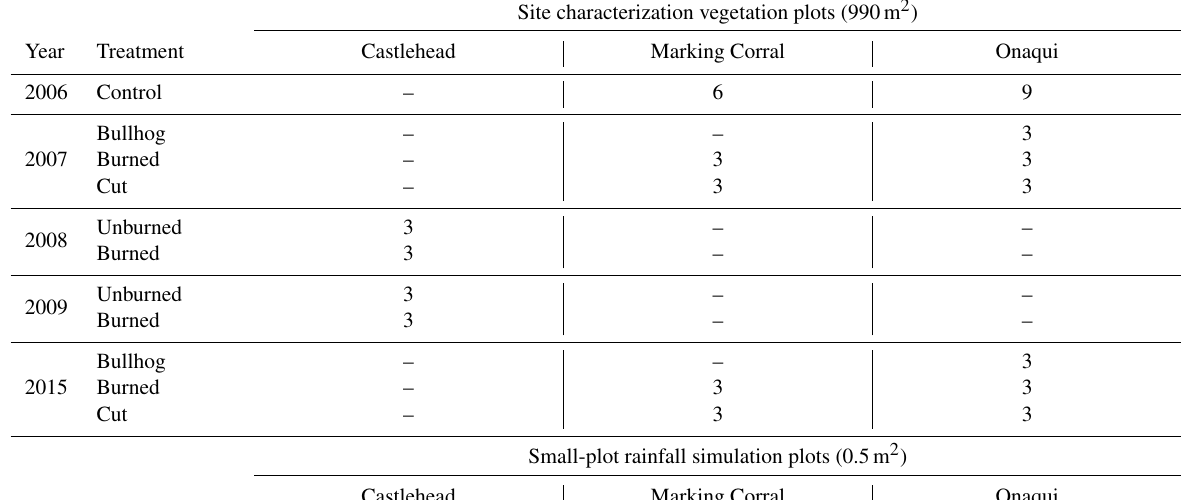
Table 2. Number of plots sampled by plot type (site characterization vegetation plots and small-plot rainfall, large-plot rainfall, and overland- flow simulation plots) at each study site (Castlehead, Marking Corral, and Onaqui) by treatment and microsite (small plots – tree coppice, shrub coppice, and interspace; large plots and overland flow – tree zone and shrub–interspace zone (intercanopy)) combination each year of the study. Control refers to untreated areas at Marking Corral and Onaqui sites. Unburned refers to areas immediately adjacent to, but outside of, the wildfire area (burned treatment) at the Castlehead site. Downed tree subtreatments (cut–downed tree and unburned–downed tree) refer to plots with a single downed tree across each respective plot within the specified associated treatment (cut or unburned). Tree and shrub coppice microsites are areas underneath or previously (prior to treatment) underneath tree and shrub canopy, respectively. Interspace microsites are areas between tree and shrub coppice microsites. Tree zone microsites are areas underneath, or previously underneath, and immediately adjacent (just outside canopy drip line) to a tree canopy. Shrub–interspace zones are the areas between tree canopies, collectively inclusive of shrub coppice and interspace microsites (the